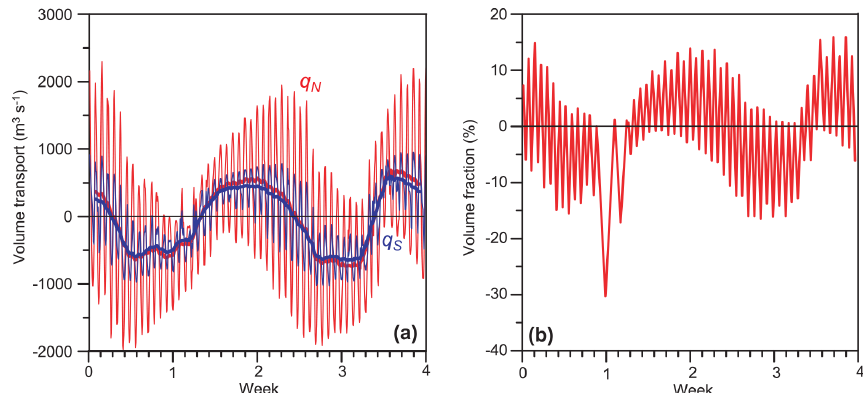
Figure 5. (a) Hourly (thin lines) and 25h averaged (thick lines) simulated northward volume transport across the northern sill, q N (red), and across the southern sill, q S (blue). (b) Fraction of total volume transported into (positive) or out of (negative) the strait across the northern sill during each uni-directional period.